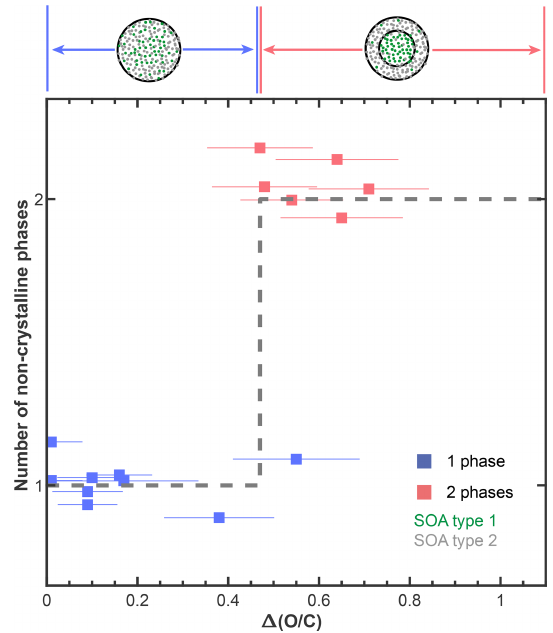
Figure 4. Summary of the number of phases observed in our inter- nally mixed SOA + SOA particles as a function of the absolute dif- ference in the average O / C ratios between the two SOA types within a mixture, (cid:49) (O / C) = | O / C SOA1 − O / C SOA2 | . The horizontal error bars indicate the propagated error from the 12% relative uncertainty of the O / C ratios determined for each SOA type (average absolute value of relative error for multi-species organic aerosol; Table S3; Canagaratna et al., 2015). The black, dashed line shows an empiri- cal classification of the form of Eq. (1) to our phase behavior data. The data points are randomly vertically offset around values of 1 and 2 for clarity and to reduce the overlap between the data